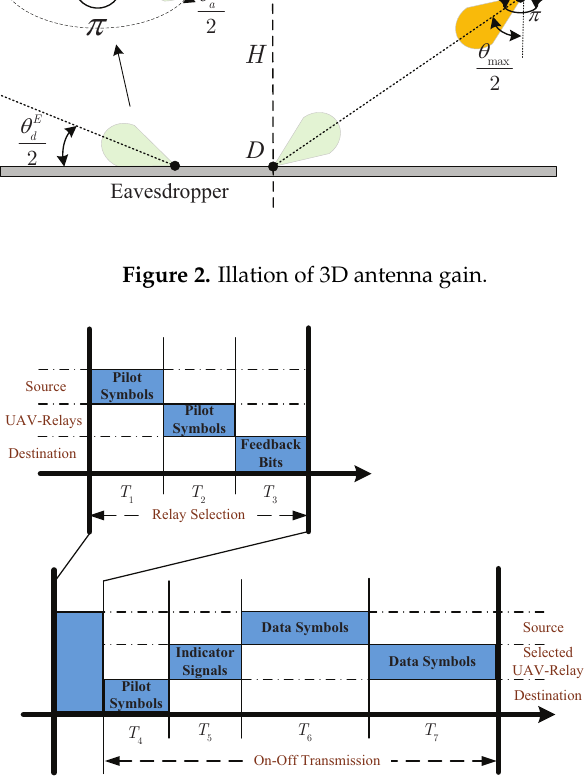
Figure 3. Scheduling period of the relay selection and on-off transmission